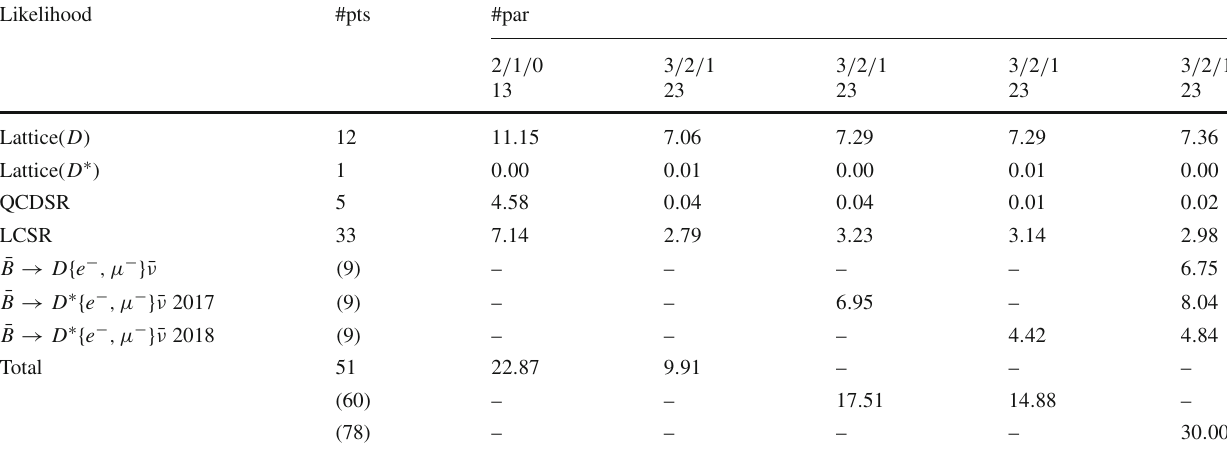
Table 1 Summary of the goodness of fit in terms of the χ 2 values at the best-fit point for all combinations of fit models and datasets. The largest single pull arises from the QCDSR constraint on χ (cid:8)